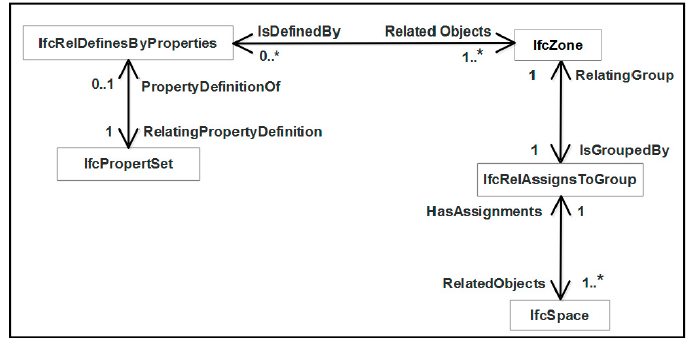
Figure 3. IFC extension model for 3D cadastre [7].